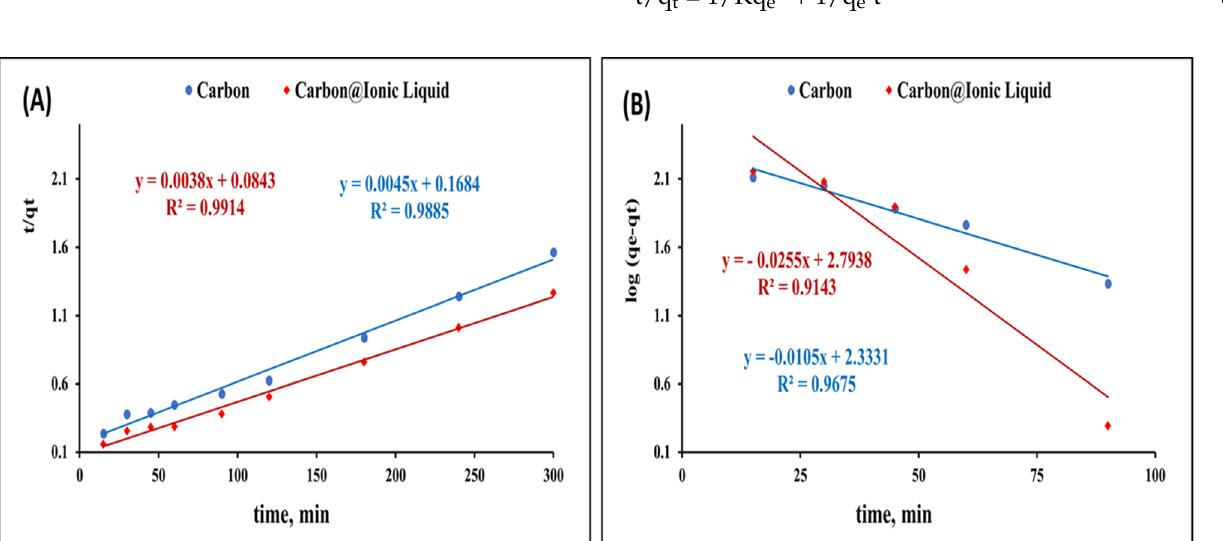
Figure 5. Kinetic investigation for the adsorption of benzothiophene onto carbon and tri- hexYl(tetradecyl)phosphonium dicyanamide-modified renewable carbon: second-order kinetic model ( A ) and first-order kinetic model ( B ).